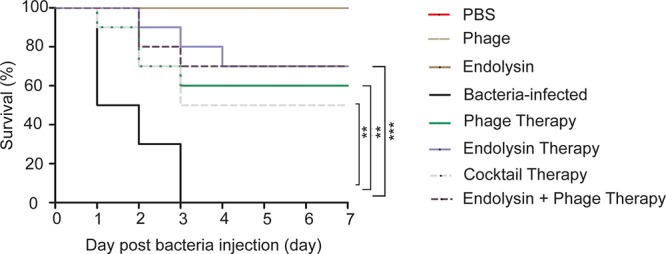
Therapeutic efficacy of Phage PD6A3 and endolysin Ply6A3 against mice A. baumannii sepsis infections. Survival of mice that were sepsis infected with AB32 and then treated with endolysin Ply6A3, phage PD6A3; or only intraperitoneal injected with PBS, Phage, endolysin. Using log-rank (Mantel-Cox) test. Each group harbors 10 mice. ∗∗P < 0.01, ∗∗∗P < 0.001 compared with the Bacteria group. PD6A3, a novel Acinetobacter baumannii Phage. Ply6A3, the endolysin encoded by a novel Acinetobacter baumannii Phage PD6A3 gene. AB32, the No. 32 strains of Multidrug Resistance Acinetobacter baumannii.